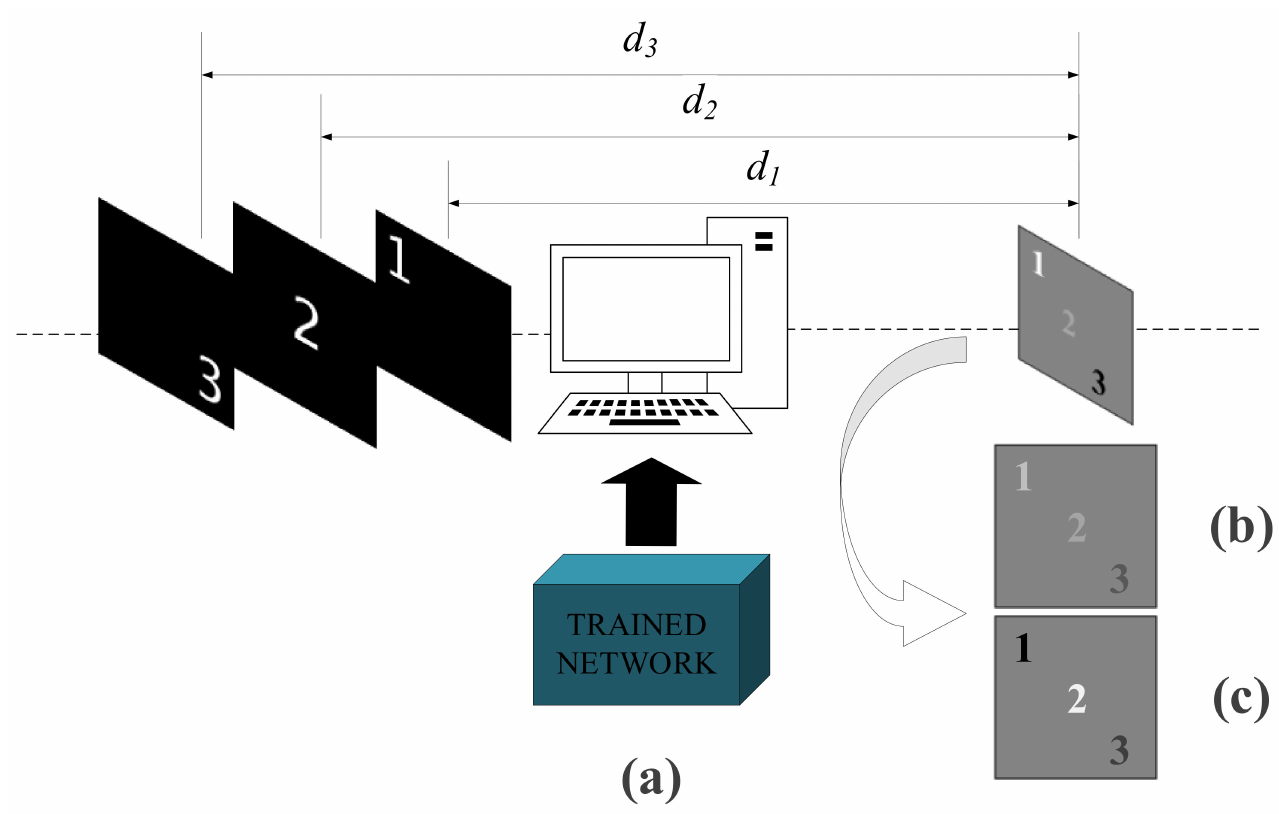
Figure 5. Diagram of generating holograms from input images using deep learning. ( a ) trained network, ( b ) real part of hologram, ( c ) imaginary part of